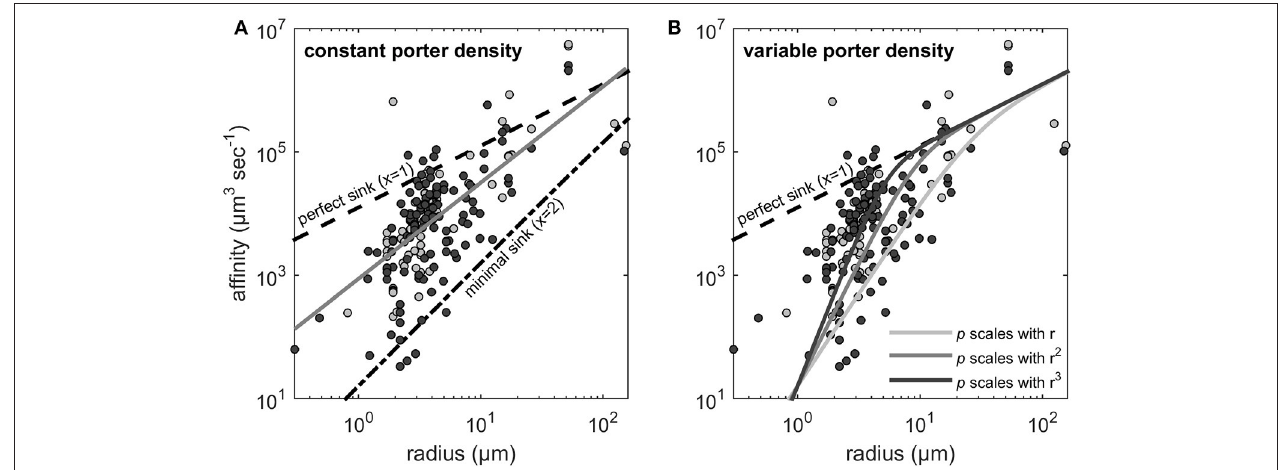
FIGURE 2 | Scaling exponents ( x ) of the allometric relationship between uptake affinity and cell radius. Light gray and dark gray dots represent the affinity estimates that were extracted from Edwards et al. (2015) for nitrate (N) and phosphate (P), respectively. The dashed line indicates the theoretical maximum affinity, which corresponds to perfect sink ( x = 1 ) obtained for p = 1 (Equation 2). (A) The gray line is the fit to the data from Edwards et al. (2015) using OLS regression which provides x = 1.55 (see Method). The dash-dotted line indicates the minimal sink ( x = 2 ) obtained for p → 0 . (B) Scaling exponents larger than 2 are expected if transporter density increases with cell size. The three solid lines illustrate the expected scaling when transporter density increases with r , r 2 , and r 3 , respectively. Equation (2) is fundamentally not a power function and therefore the indicated scaling exponents represent only the initial and steepest part of the lines.